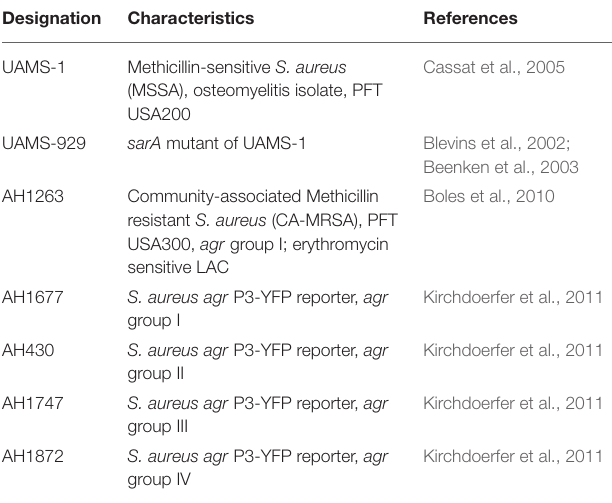
TABLE 2 | Summary of S. aureus strain